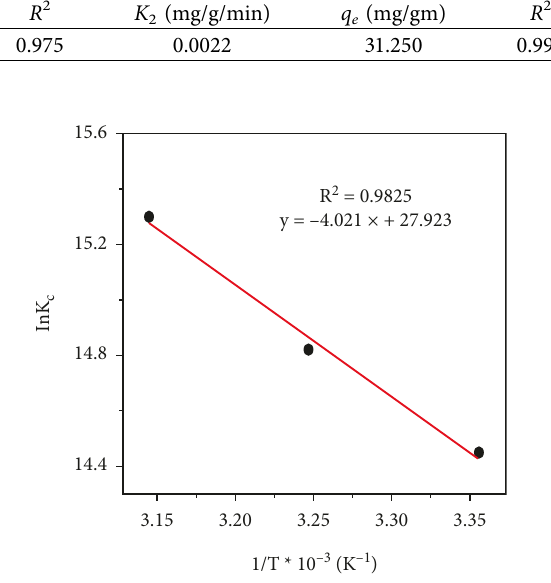
Figure 11: Van’t Hoff plot of lnKC as a function of 1/T. Table 4: Thermodynamic parameters of CADSP and Cr(VI)